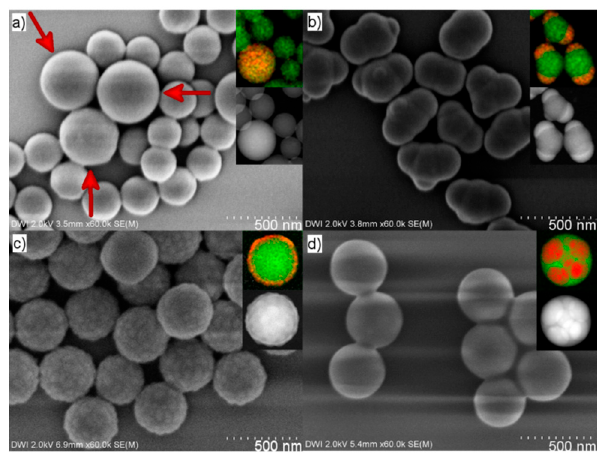
Figure 4. SEM images of nanoparticles resulting from ( a ) the addition of polystyrene particles after emulsion formation (red arrows indicate polyphenylsiloxane particles); ( b ) synthesis without pretreatment; ( c ) with pretreatment at room temperature; and ( d ) using polystyrene particles without cross-linker (inlays show EDS mappings; green = carbon, red = silicon).